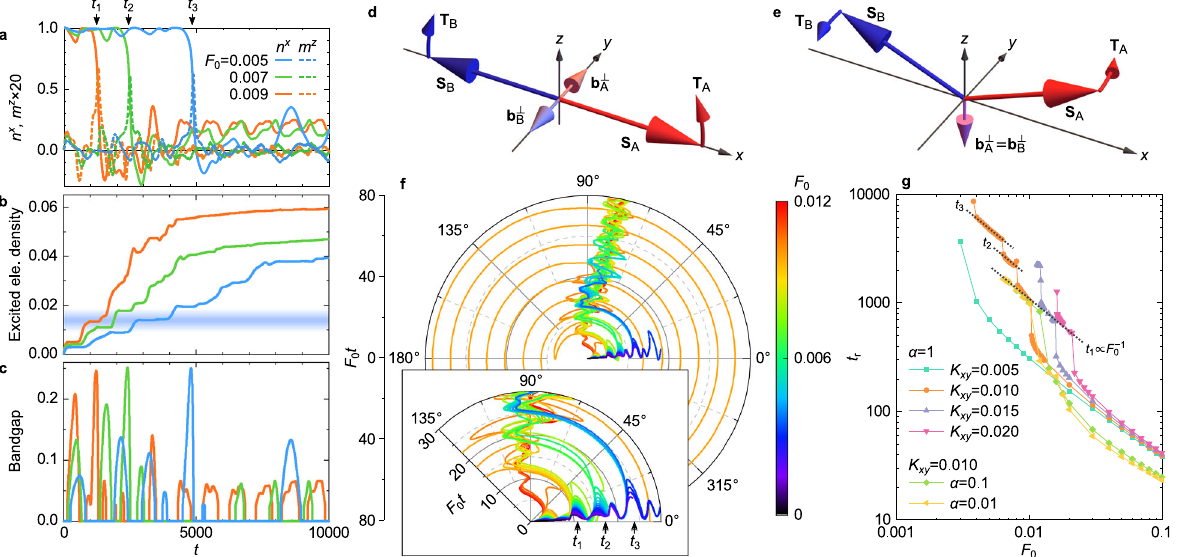
Fig. 2 Real-time dynamics induced by the constant electric fi eld. a – c The time evolution of a the Néel vector and uniform magnetization, b excited electron density, and c energy bandgap, as functions of time t in units of ħ / h 1 = 0.66 fs. d Sketch of NSOTs T A and T B acting on and b ? represent effective fi elds perpendicular to S A and S B , respectively. Uniform sublattice moments S A and S B , respectively. Arrows of b ? A B magnetization appears in the [001] direction because of NSOT, and it induces another effective fi eld attributed to the easy-plane anisotropy that rotates the Néel vector as shown in ( e ) with the z components exaggerated. f Polar plots of the in-plane angle of the Néel vector as a function of the dimensionless time F 0 t for F 0 = 0.0004 – 0.012. The inset of ( f ) is the enlarged view from F 0 t = 0 to 30. g Time t r for the Néel vector to rotate towards the [010] (or ½ 010 (cid:4) ) direction as a function of F 0 . The electric fi eld is applied in the [110] direction in ( a – g ).